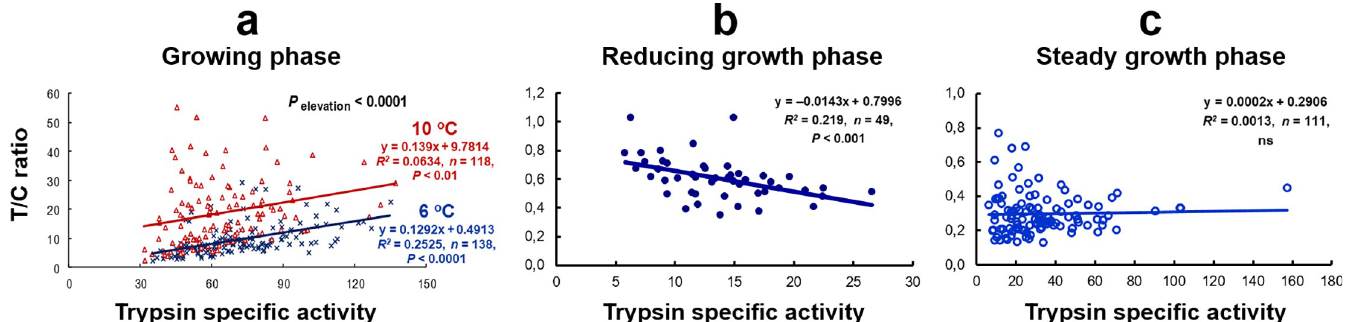
Fig 9. Growth status studies by the relationship between trypsin specific activity and the activity ratio of trypsin to chymotrypsin (T/C ratio) in the pyloric caeca with food content. (a) During the growing phase in Atlantic salmon parr reared at 6 o C ( × ) and 10 o C ( Δ ) (adapted from [9], with permission from Springer Corp.). (b) During the reducing growth phase in Atlantic salmon of about 1 kg (data adapted from [28], with permission from John Wiley and Sons, Inc.). (c) During the steady growth phase in maturing rainbow trout (data adapted from [13], with permission from Hindawi Publishing Corp.). The enzyme specific activities of trypsin and chymotrypsin are expressed as μ mol p -nitroaniline produced h –1 mg protein –1 . ns, not significant.